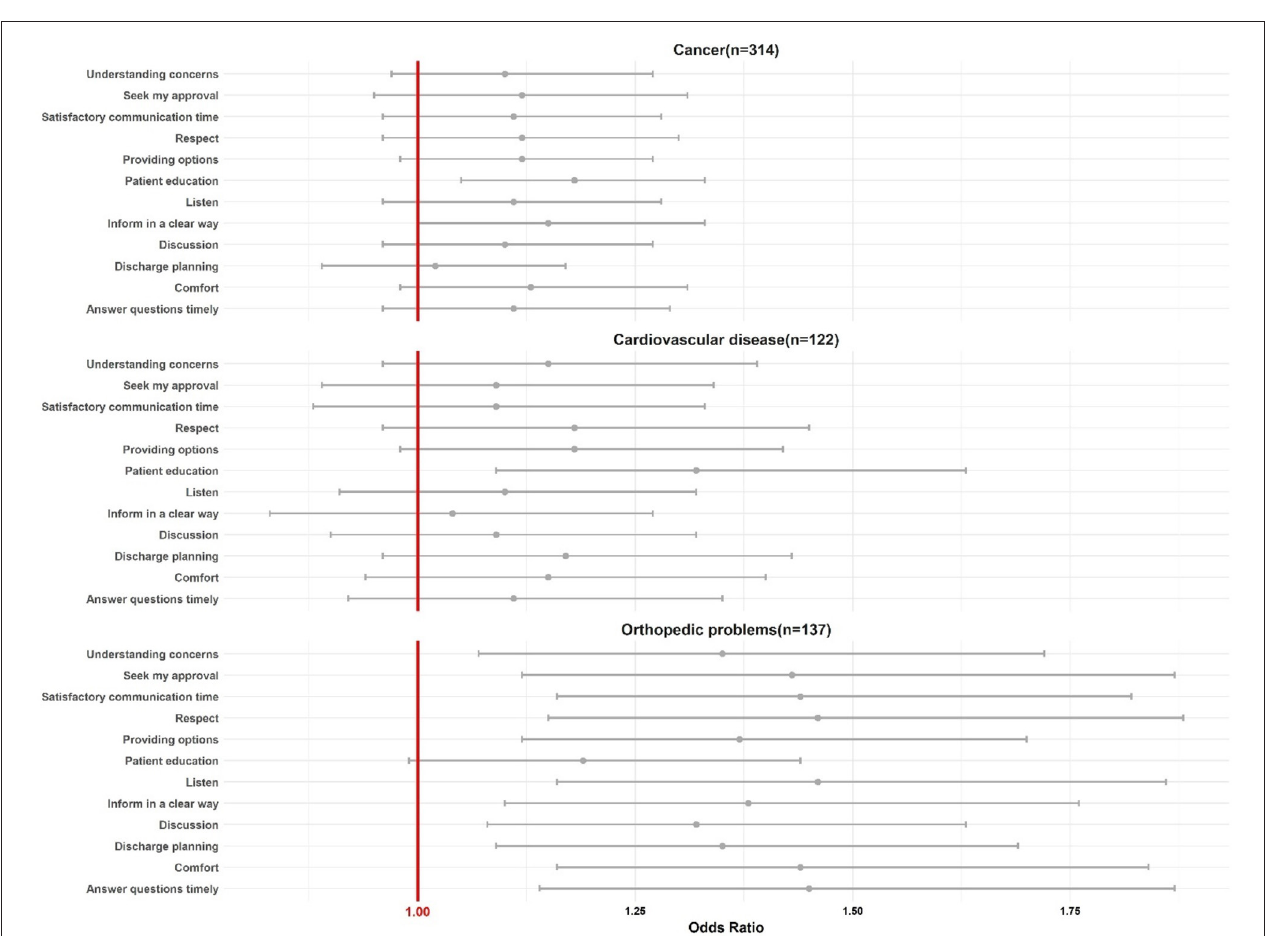
Frontiers in Psychiatry |